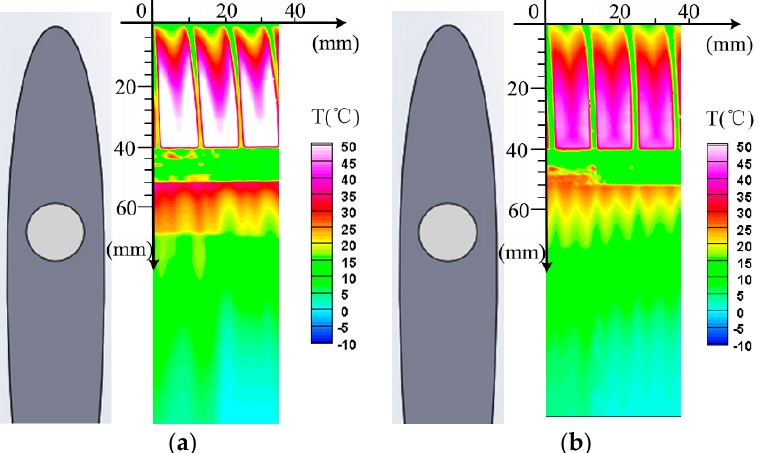
Figure 11. The surface temperature distribution 80 s after NS-DBD plasma actuator was switched on under the condition of U = 65 m/s, T = − 10 °C, LWC = 0 g/m 3 : ( a ) LV-HF discharge; ( b ) HV-LF discharge.